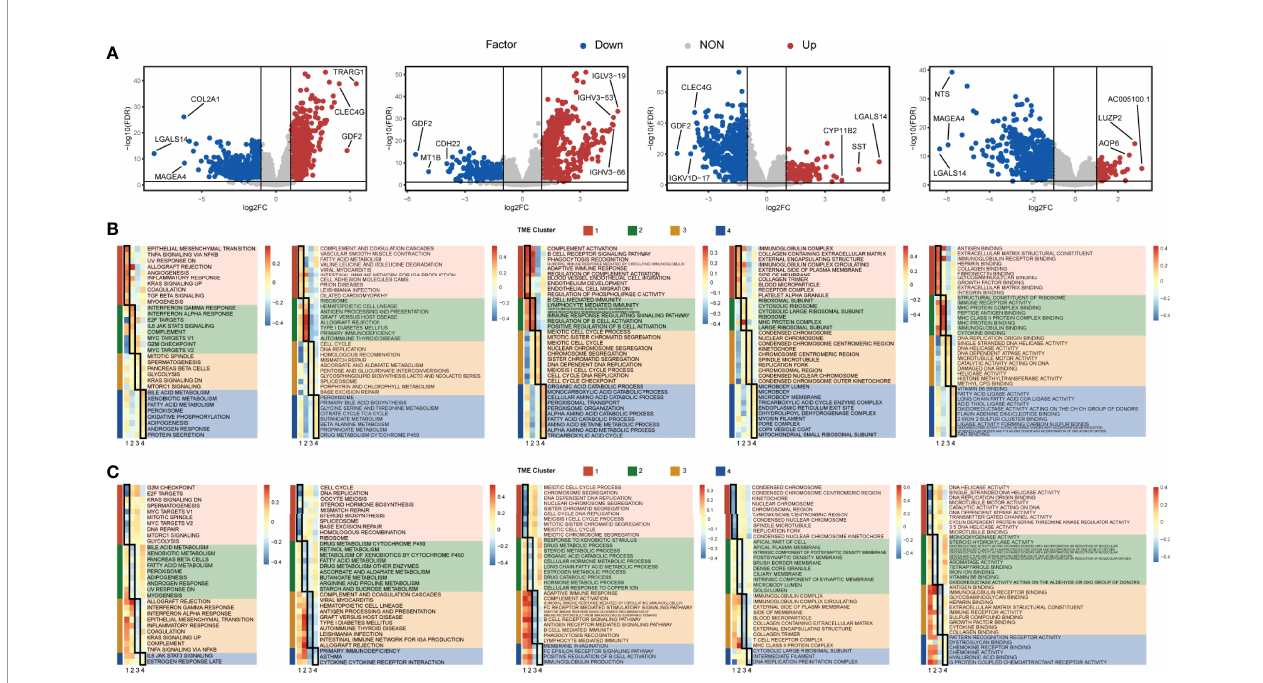
FIGURE 4 | Differentially expressed genes and enriched functions in the TME cluster. (A) The volcano map showed the differentially expressed genes of each cluster. Red dots represent upregulated genes, blue dots represent downregulated genes, and gray dots represent no differentially expressed genes. (B) The Hallmark, KEGG, Gene Ontology Biological Process (GOBP), Gene Ontology Cellular Component (GOCC), and Gene Ontology Molecular Function (GOMF) enrichment analyses were performed for upregulated genes in each cluster, respectively. (C) The above enrichment analyses were performed for downregulated genes in each cluster,